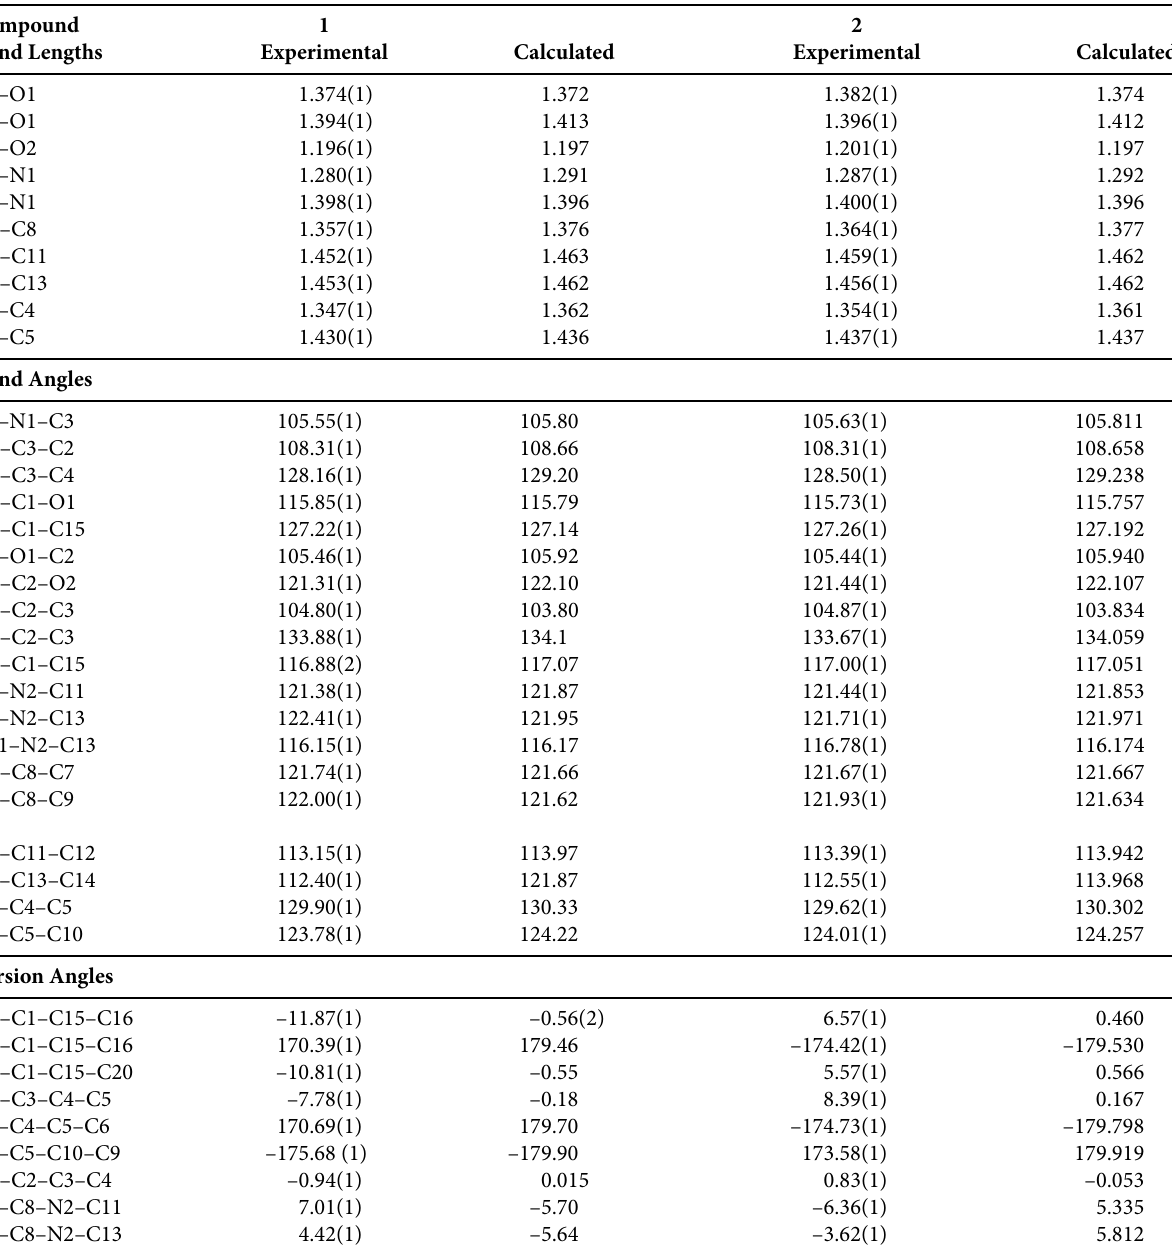
Table 2 . Selected interatomic distances (Å), angles and torsion angles (°) for the compounds 1 and 2 as observed experimentally and as calculated using DFT/ B3LYP/6-311G(d,p) method. Compound 1 2 Bond Lengths Experimental Calculated Experimental